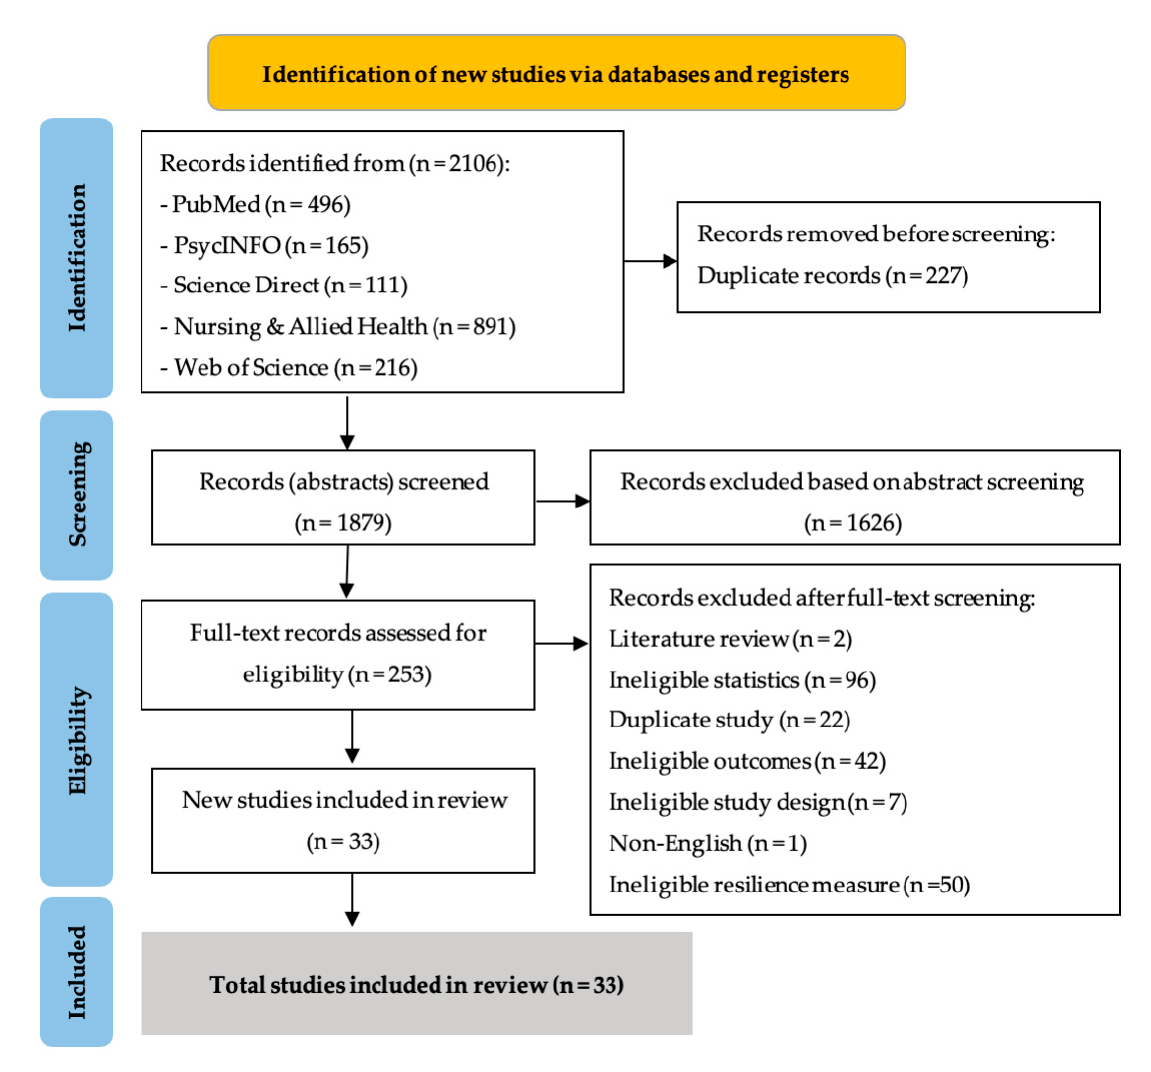
Figure 1. PRISMA flow diagram for systematic review.